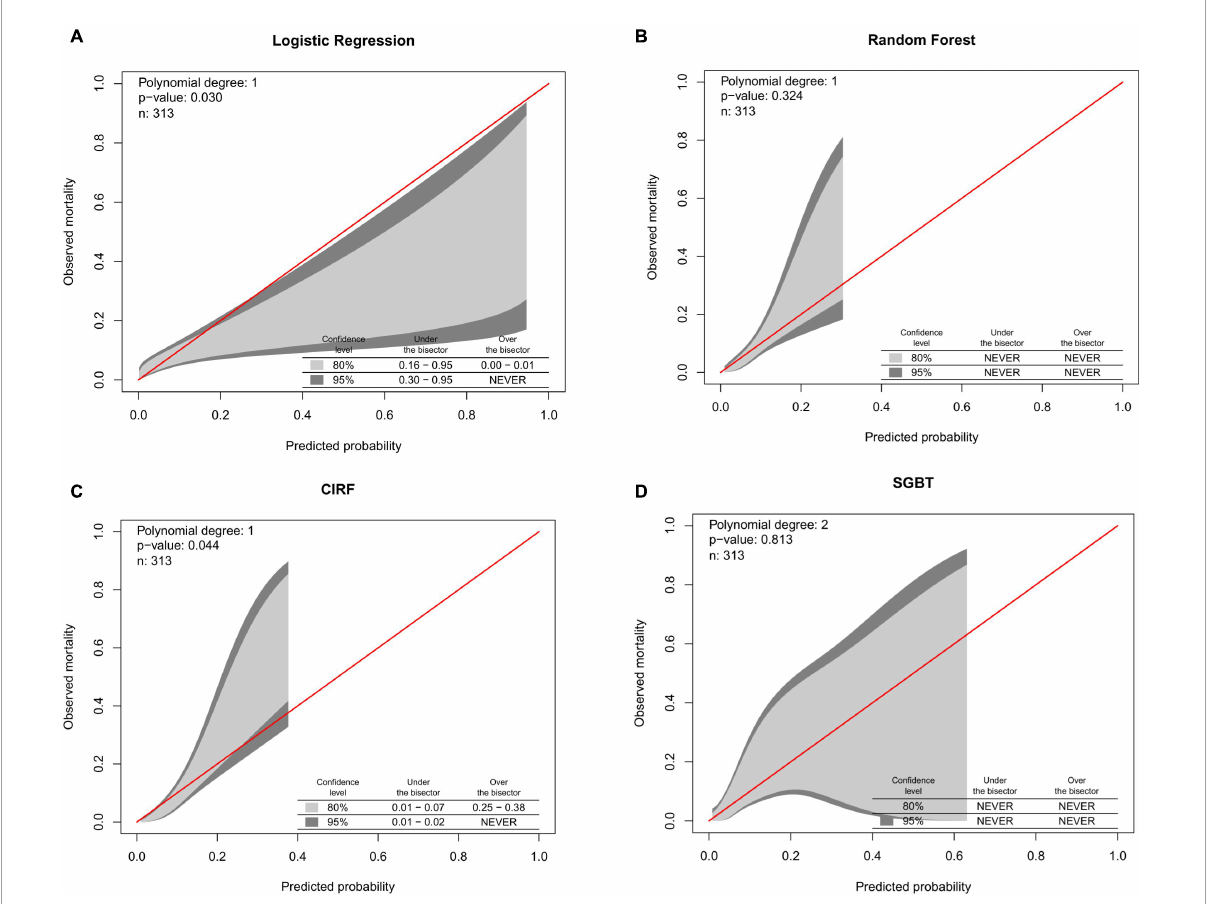
FIGURE3 Calibration belts of (A) logistic regression. (B) Random forest. (C) Conditional inference random forest. (D) Stochastic gradient boosting for postoperative major bleeding prediction in the test